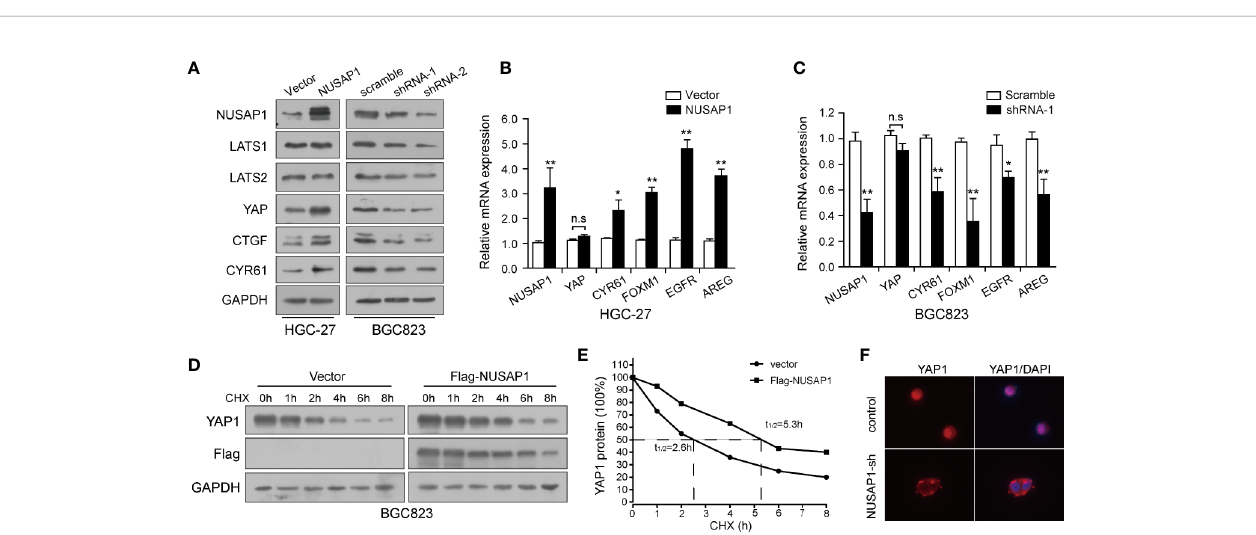
FIGURE 4 | NUSAP1 depletion impedes xenograft tumor growth in vivo . (A) Growth curves of xenograft tumors derived from BGC823 cells that expressed scramble or NUSAP1 shRNAs. Data are represented as the mean ± SEM, n = 6. (B) The images of xenograft tumors that were harvested at the end of the experiment. (C) Quanti fi cation of the average weights of collected tumors from the above experiments. (D) The protein levels of NUSAP1, YAP1, and CTGF were detected in six tumors by Western blotting. (E) The mRNA levels of NUSAP1, YAP1, and CTGF were detected in six tumors by qRT-PCR (mean ± SEM, n = 6). ** p <0.01 by two-tailed t test.